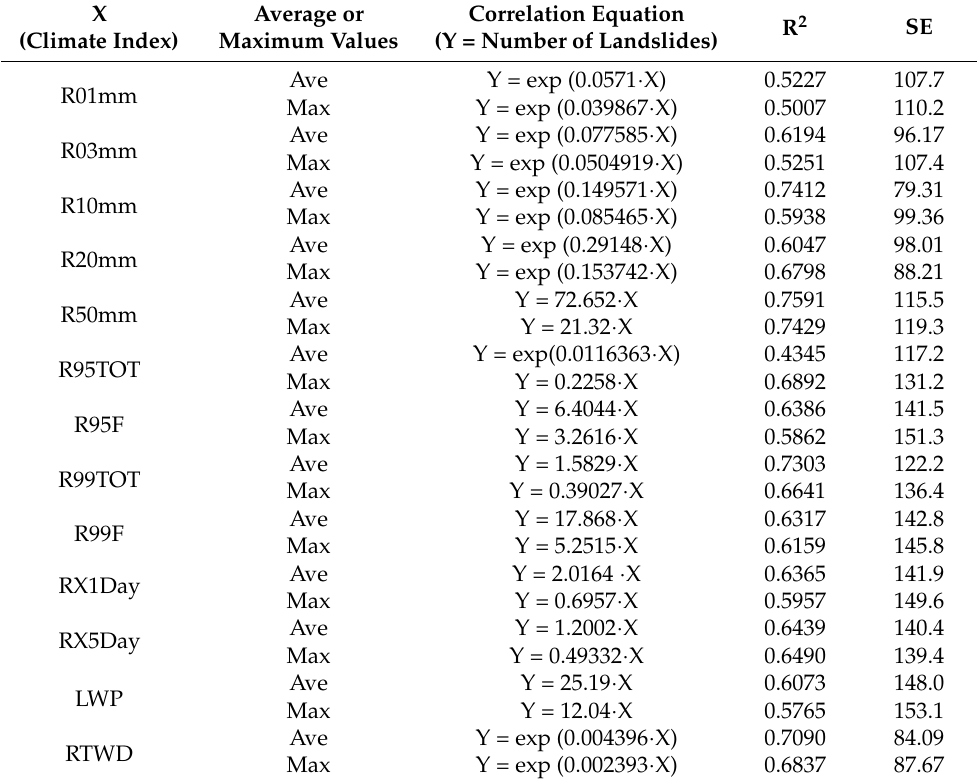
Table 2. The best fitting models between the climate indices (for average and maximum values) and the annual number of landslides occurred in